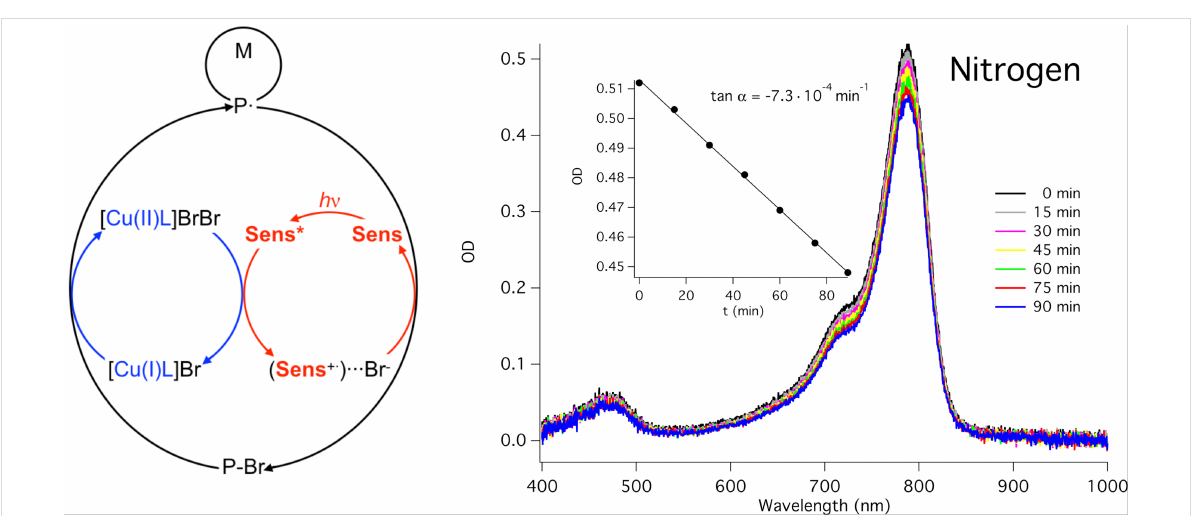
Figure 5: Spectral changes of the solution of 48 in the presence of [Cu(L)]Br2 (L: tris(2-pyridylmethyl)amine) and ethyl α -bromophenylacetate (EBPA) in DMF upon irradiation at 790 nm under